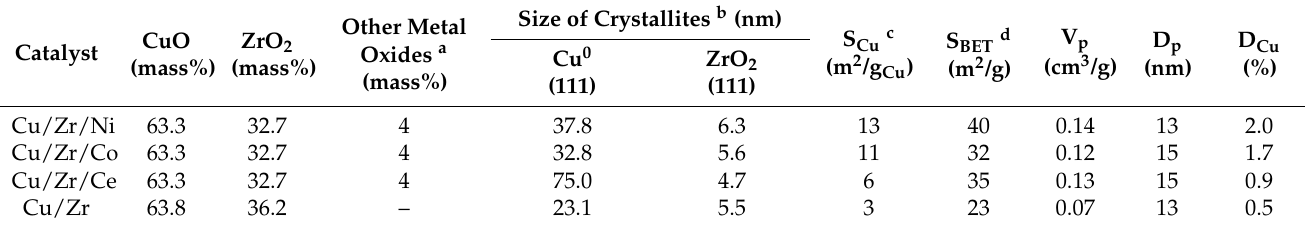
Table 1. Composition, textural properties, and size of crystallites of tested catalysts.